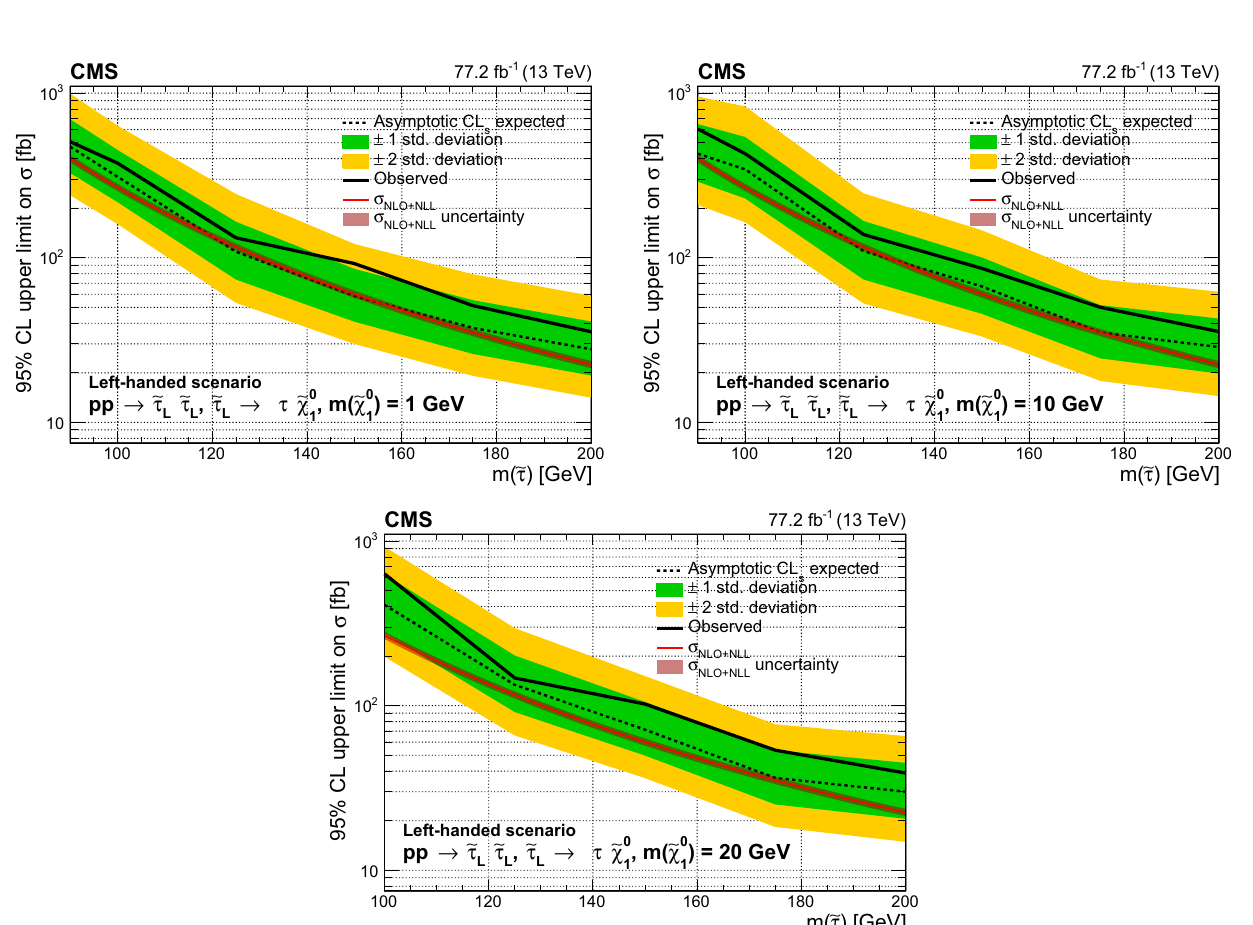
Fig. 8 Upper limit on the cross section ( σ ) of (cid:2) τ pair production and outer (yellow) bands indicate the respective regions containing 68 and 95% of the distribution of limits expected under the background- excludedat95%CLasafunctionofthe (cid:2) τ massinthepurelyleft-handed (cid:2) τ models for a (cid:2) χ 0 only hypothesis. The solid red line indicates the NLO+NLL prediction mass of 1GeV (upper left), 10GeV (upper right) and 1 forthesignalproductioncrosssectioncalculatedwith Resummino [37], 20GeV (lower). The results shown are for the statistical combination of τ while the red shaded band represents the uncertainty in the prediction the 2016 and 2017 data in the τ and (cid:2) τ analyses. The inner (green) h h h